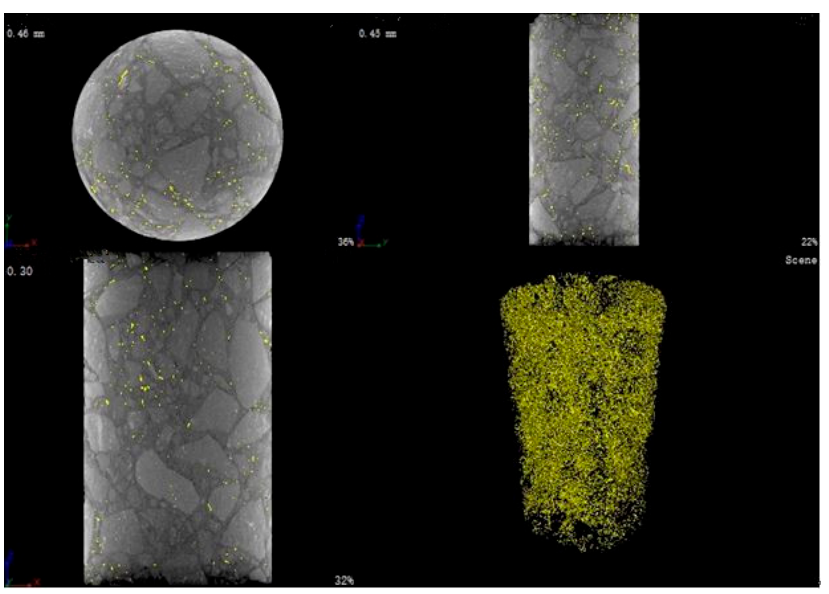
Figure 3. Extract the void information of reconstructed specimens. Table 10. The reconstructed void (%) of different molding mixtures.